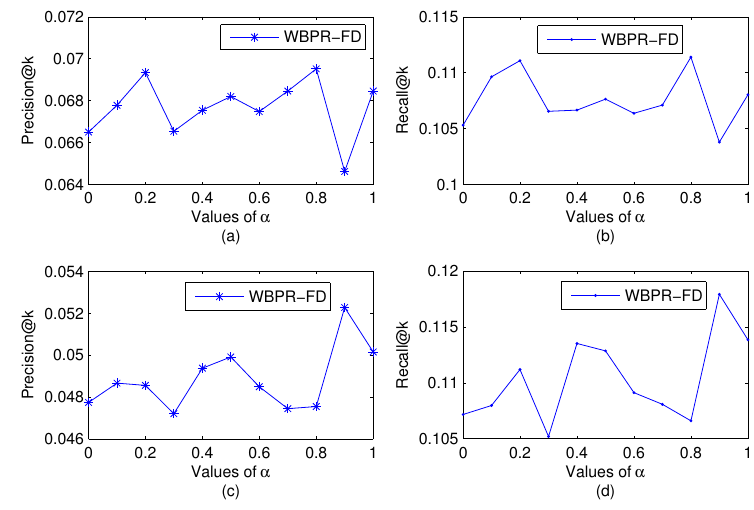
Figure 8. Impact of parameter α on the recommendation performance in Gowalla and Brightkite (dimensionality = 10, k = 5). ( a ) Precision @ k in Gowalla; ( b ) Recall @ k in Gowalla; ( c ) Precision @ k in Brightkite; ( d ) Recall @ k in Brightkite.